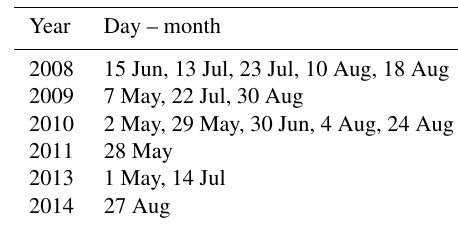
Table 1. Selected dates during Antarctic winter on which the AE index increased more than 2 standard